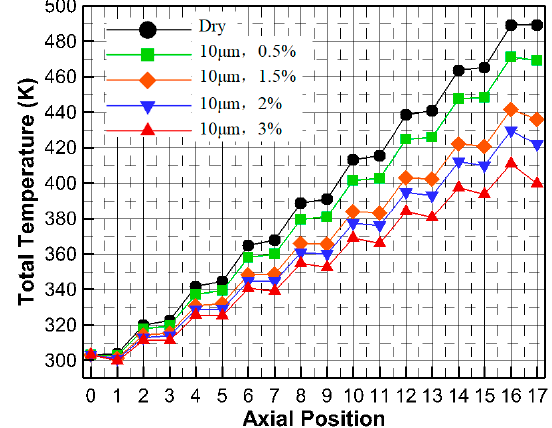
Figure 26. Axial variation of total temperature under water of different injecting rates.